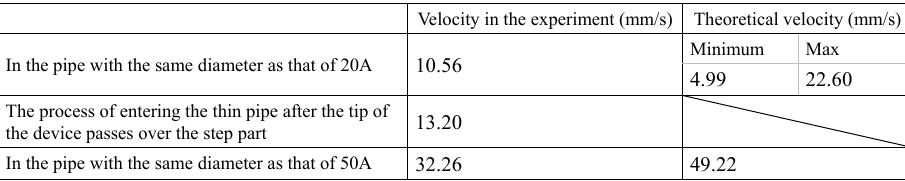
Figure 19. The velocities of the